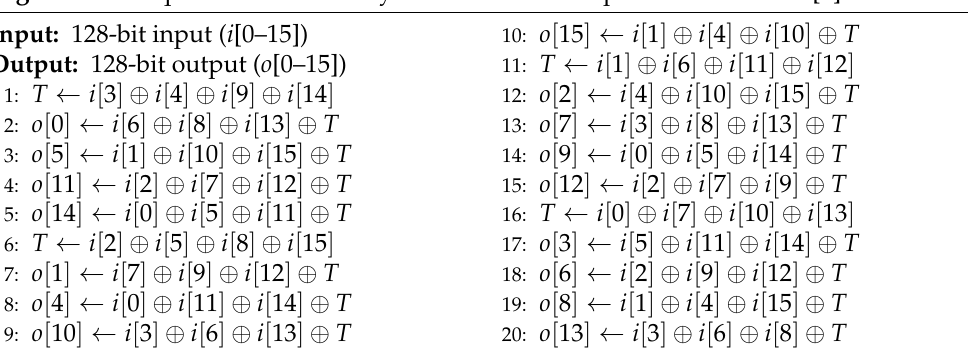
Algorithm 1 Sequential diffusion layer of ARIA block cipher for 8-bit AVR [1].